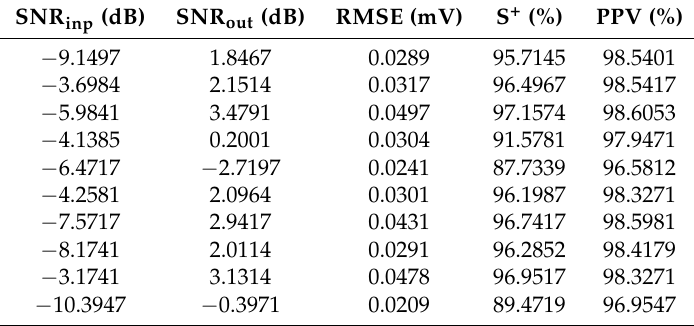
Table 2. Experimental result when using the LMS Algorithm.